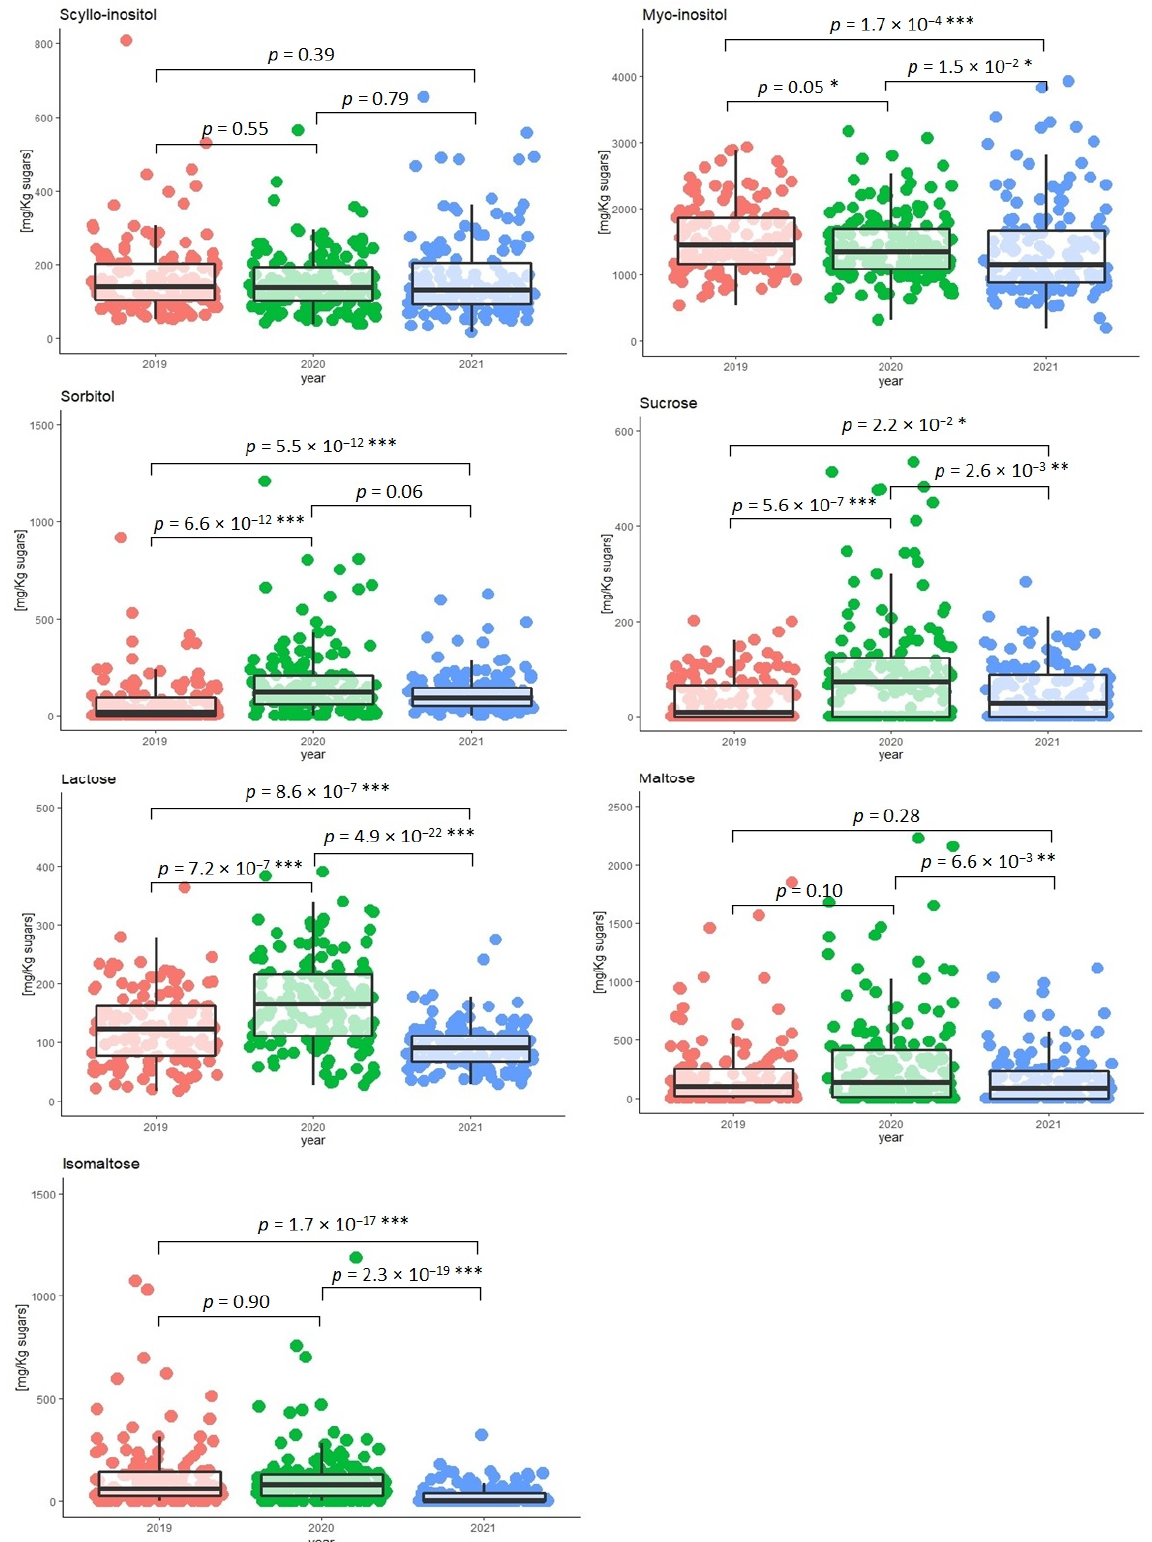
Figure 4. Box plot of the concentrations of scyllo -inositol, myo -inositol, sorbitol, sucrose, lactose, maltose, and isomaltose measured in the grape must samples collected in the harvest seasons in 2019, 2020, and 2021 (• 2019, n = 140; • 2020, n = 160; • 2021, n = 150). Signi fi cance level: * p ≤ 0.05 signi fi cant; ** p ≤ 0.01 very signi fi cant; *** p ≤ 0.001 highly signi fi cant.